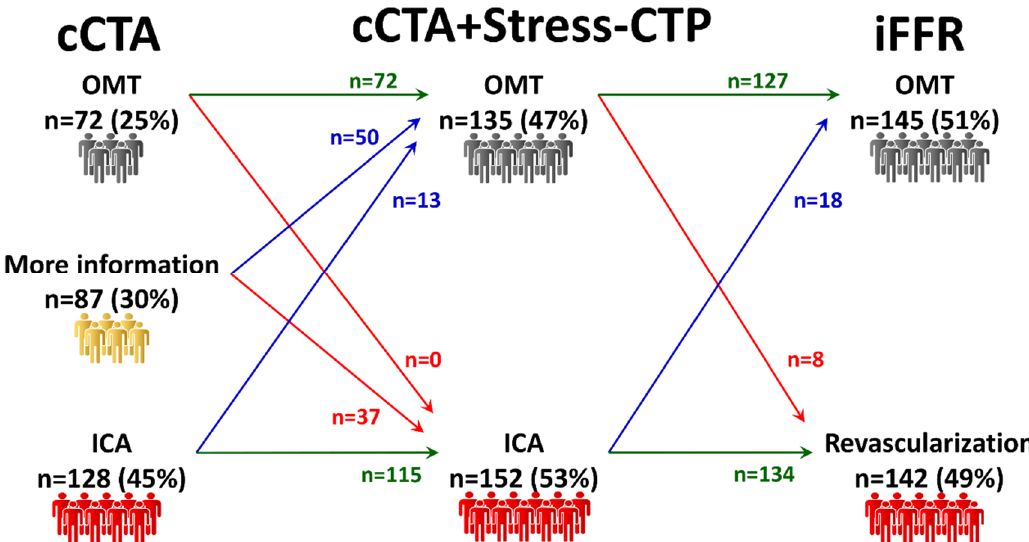
Figure 4. Management according to the addition of Stress-CTP to cCTA. If Stress-CTP is added to cCTA, more than two-thirds of patients who were previously without a clear management indication were allocated to OMT. cCTA: coronary computed tomography angiography; OMT: optimal medical treatment; ICA: invasive coronary angiography; Stress-CTP: stress computed tomography perfusion; iFFR: invasive fractional flow reserve.